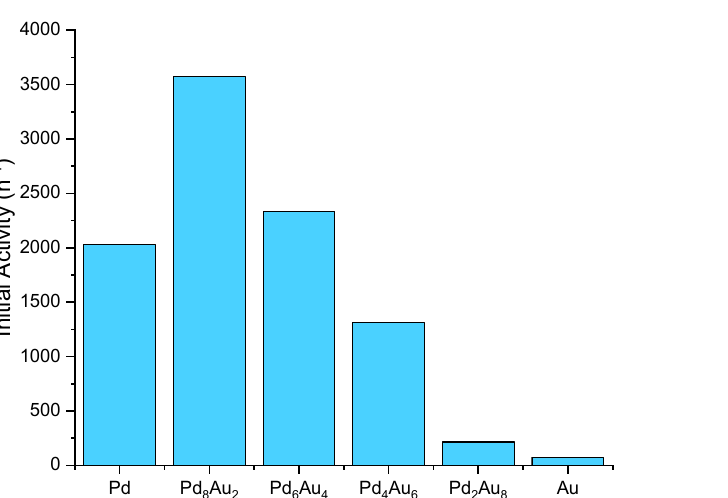
Figure 5. Initial activity of monometallic and bimetallic catalysts in the hydrogenation reaction.